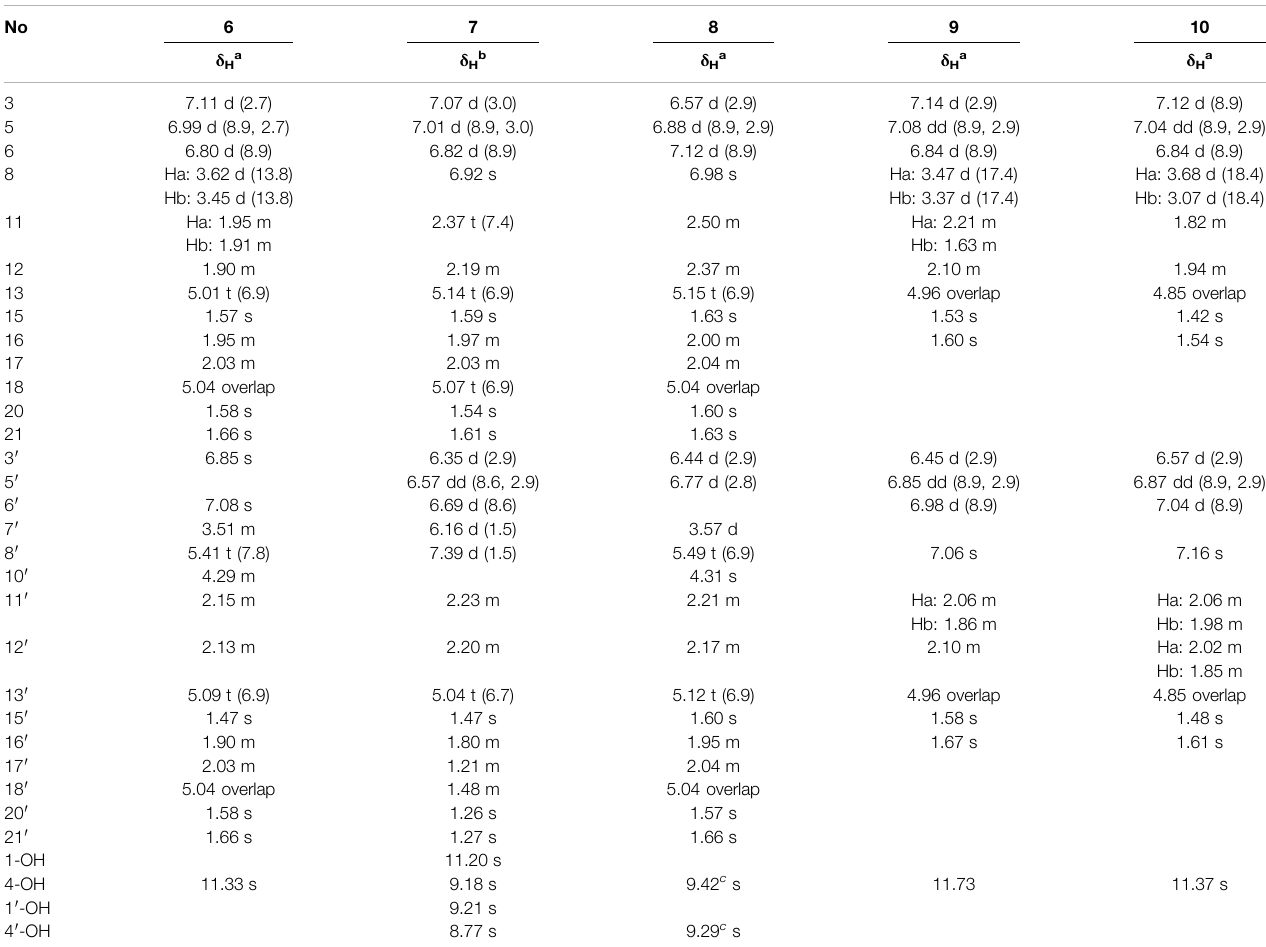
TABLE 3 | 1 H NMR data of 6 – 10 ( δ in ppm, J in